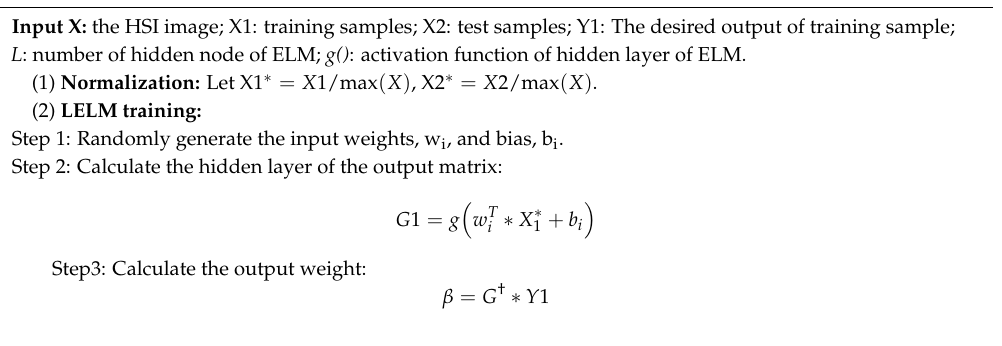
Algorithm 1 Spectral-Spatial Classification for HSI Based on LELM and